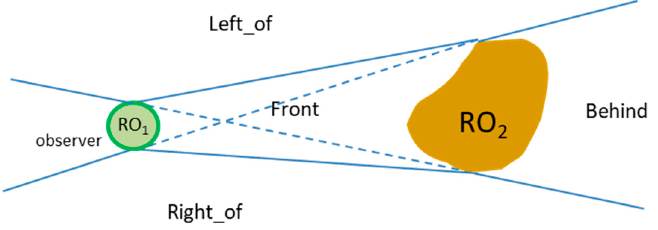
Figure 7. Deictic frame of reference .